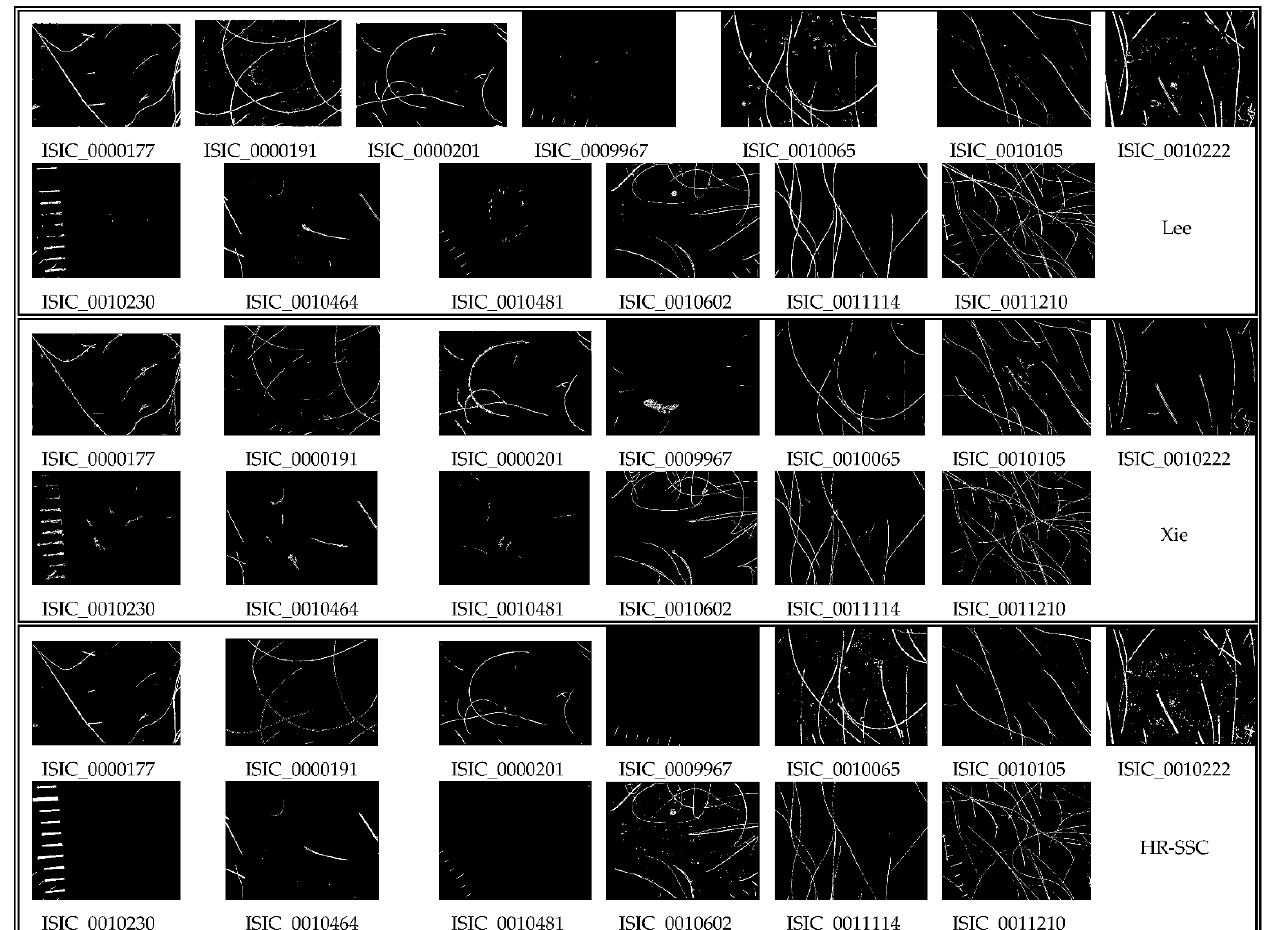
Figure 15. Resulting masks of methods Lee, Xie, and HR-SSC on sH-data . Table 1. Quality evaluation of the results on the H13GAN-data —best results are in bold. Img